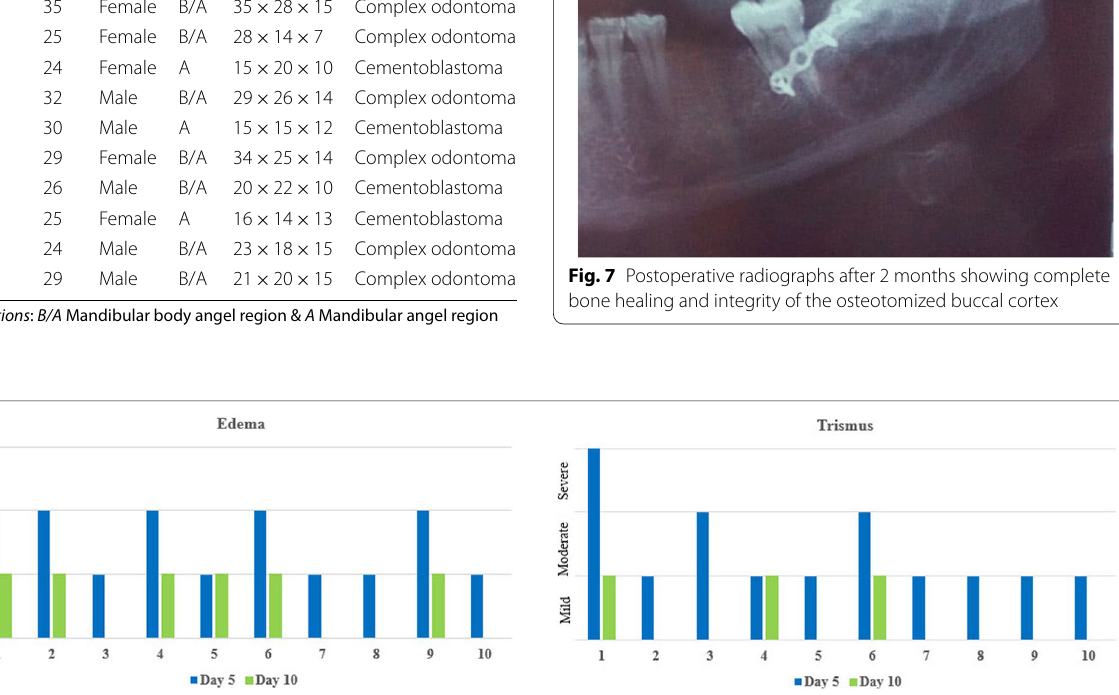
Fig. 6 Bar charts showing edema and trismus in individual